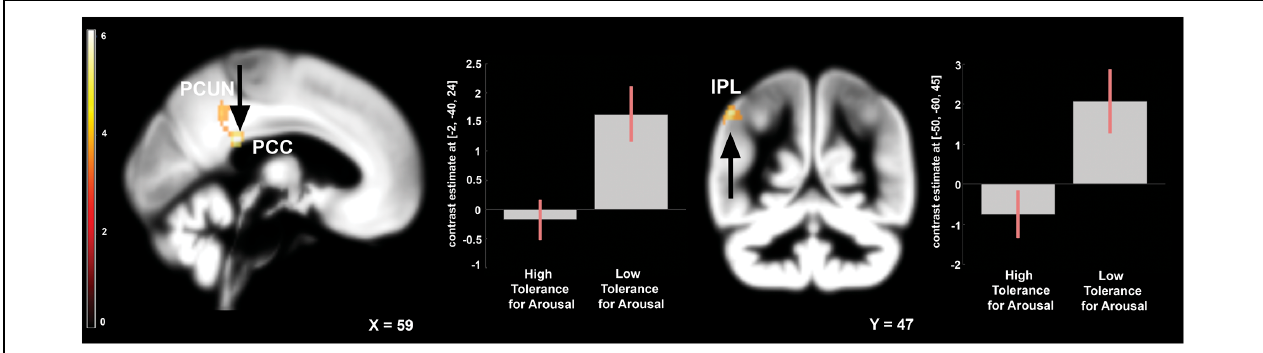
FIGURE 4 | Brain activity pattern between two groups: low arousal tolerance vs. high arousal tolerance associated with the effect of frustration induction on Braille discrimination task (Braille II vs. Braille I). Plots represent percentage signal change for peaks in PCC and IPL. All of the displayed results are located in the left hemisphere. PCC, posterior cingulate cortex; PCUN, precuneus; IPL, inferior parietal